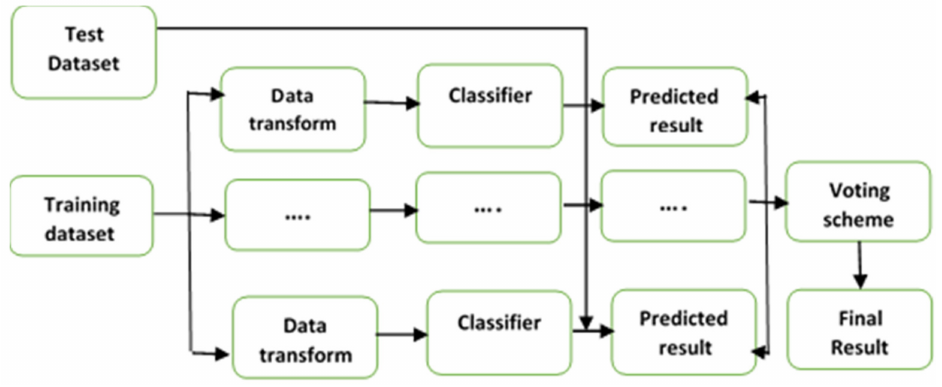
Figure 1. The ensemble classification